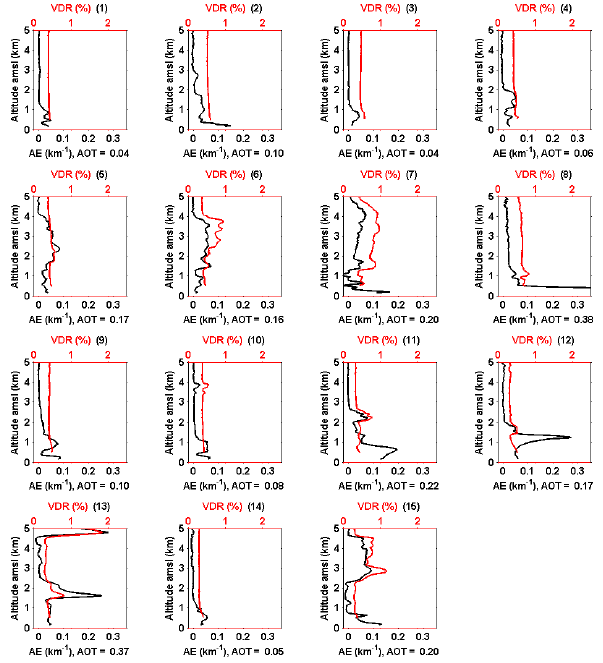
Figure 9. Same as Fig. 8 but for the ChArMEx experiment (June and July 2013).